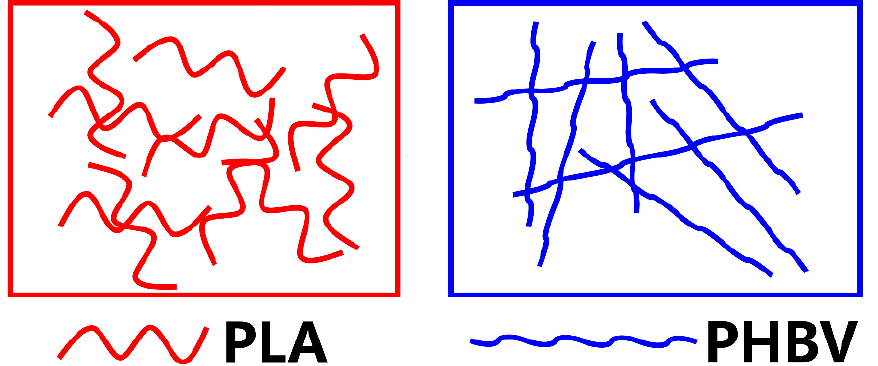
Figure 9. Scheme illustrating of Chain structure of neat PLA and PHBV.